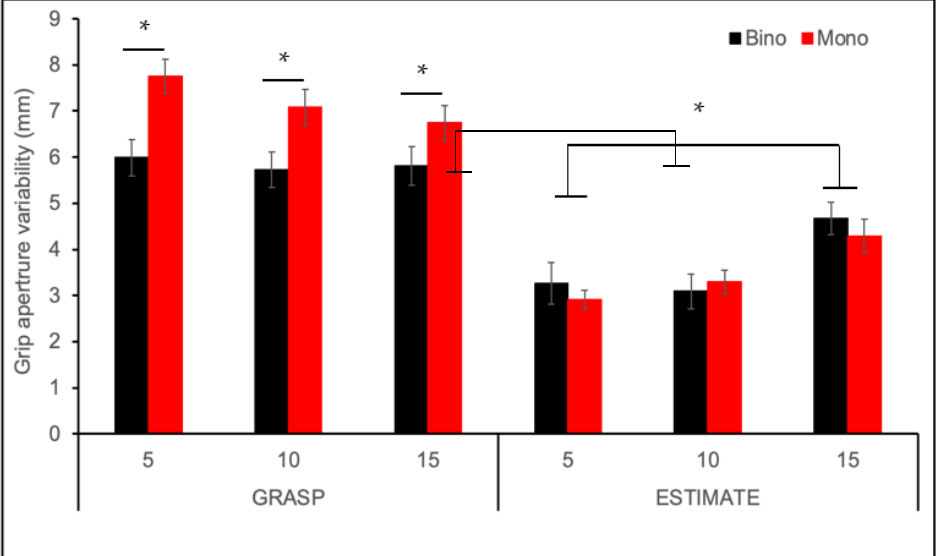
Figure 3. Grip aperture variability for binocular (Bino) versus monocular (Mono) viewing plotted across all experimental conditions. Error bars show ± 1 standard error. Grip aperture was significantly more variable during grasping compared to estimation, as well as during monocular binocular viewing during grasping (* p < 0.05). There was no effect of viewing condition for the estimation task.